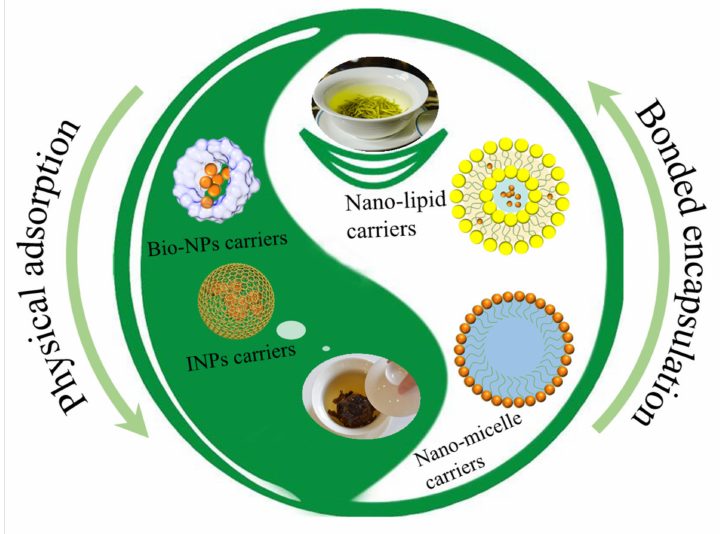
Figure 2. Schematic presentation of the nano-encapsulation of tea polyphenols by physical adsorption and chemical